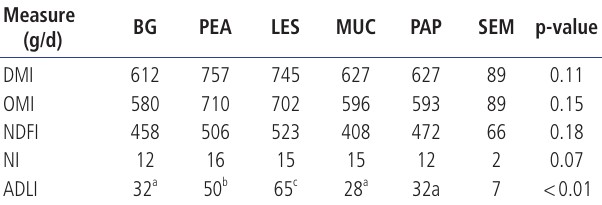
Table 2. Effects on intake of dry matter (DMI), organic matter (OMI), neutral detergent fiber (NDFI), nitrogen (NI), and acid detergent lignin (ADLI) in goats resulting from supplementing bahiagrass (BG) hay with perennial peanut (PEA), lespedeza (LES) hay, or mucuna (MUC) or papaya seeds